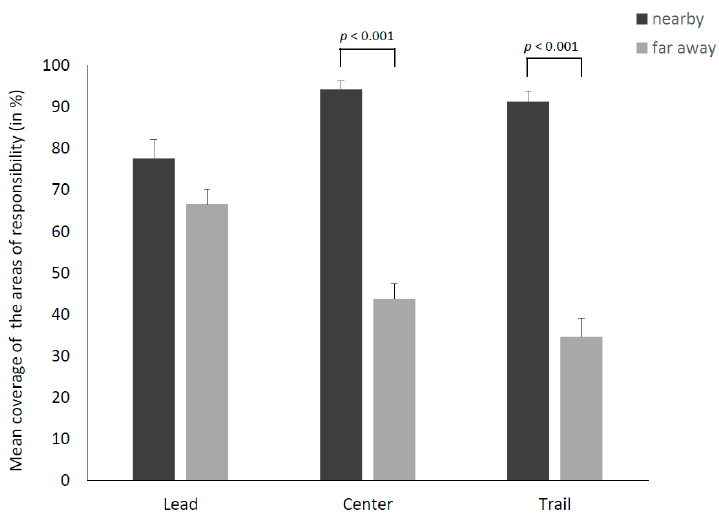
Figure 3. Mean coverage (error bars indicating standard errors) of the areas of responsibilities as a function of phase of the basketball shot and distance to the ball.